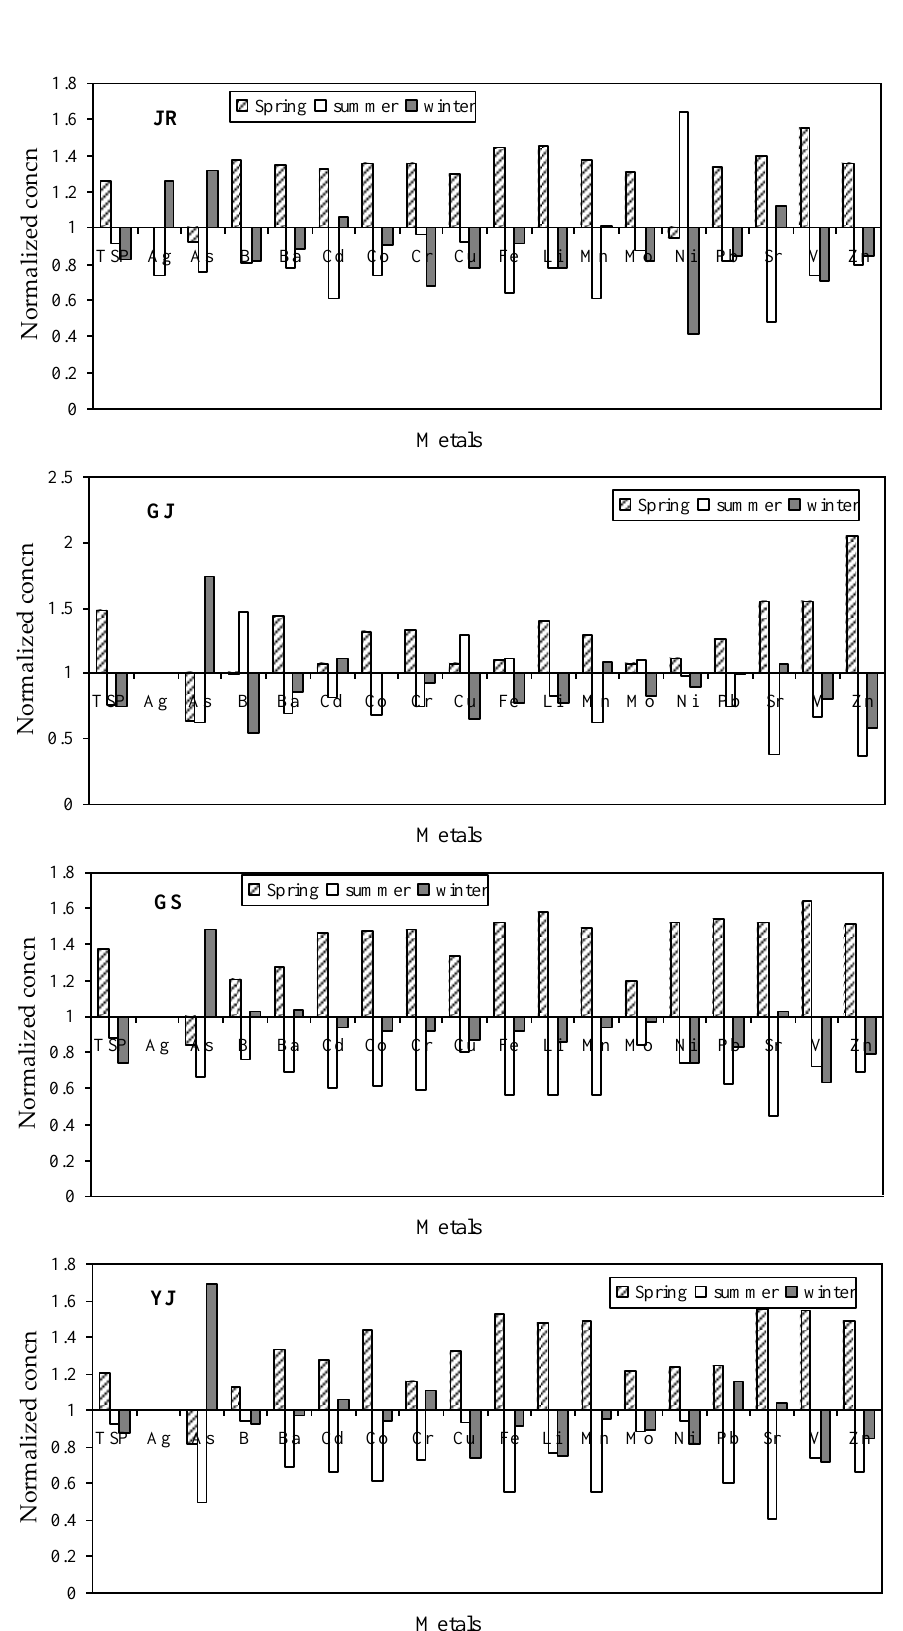
FIGURE 6. Normalization of metal species in TSP at each study site across